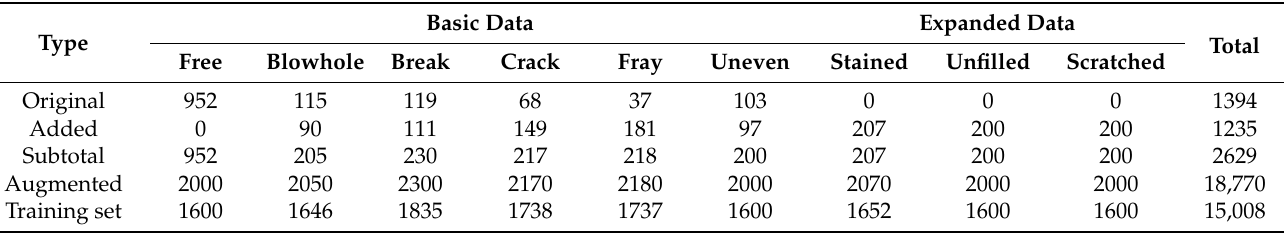
Figure 4. The appearance of experimental samples and the data augmentation of their images: ( a ) the appearance of experimental samples; ( b ) the data augmentation. Table 1. Numerical details of the